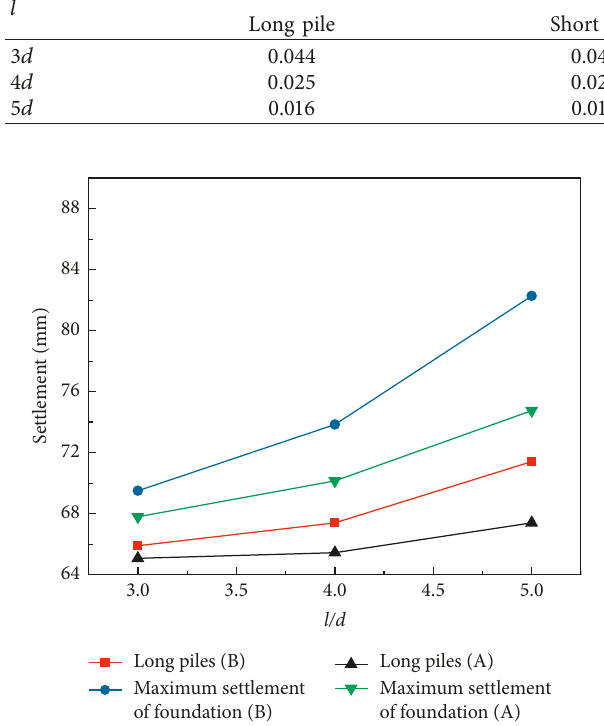
Figure 12: Influence of layout and pile spacing on the settlement of long-short pile composite